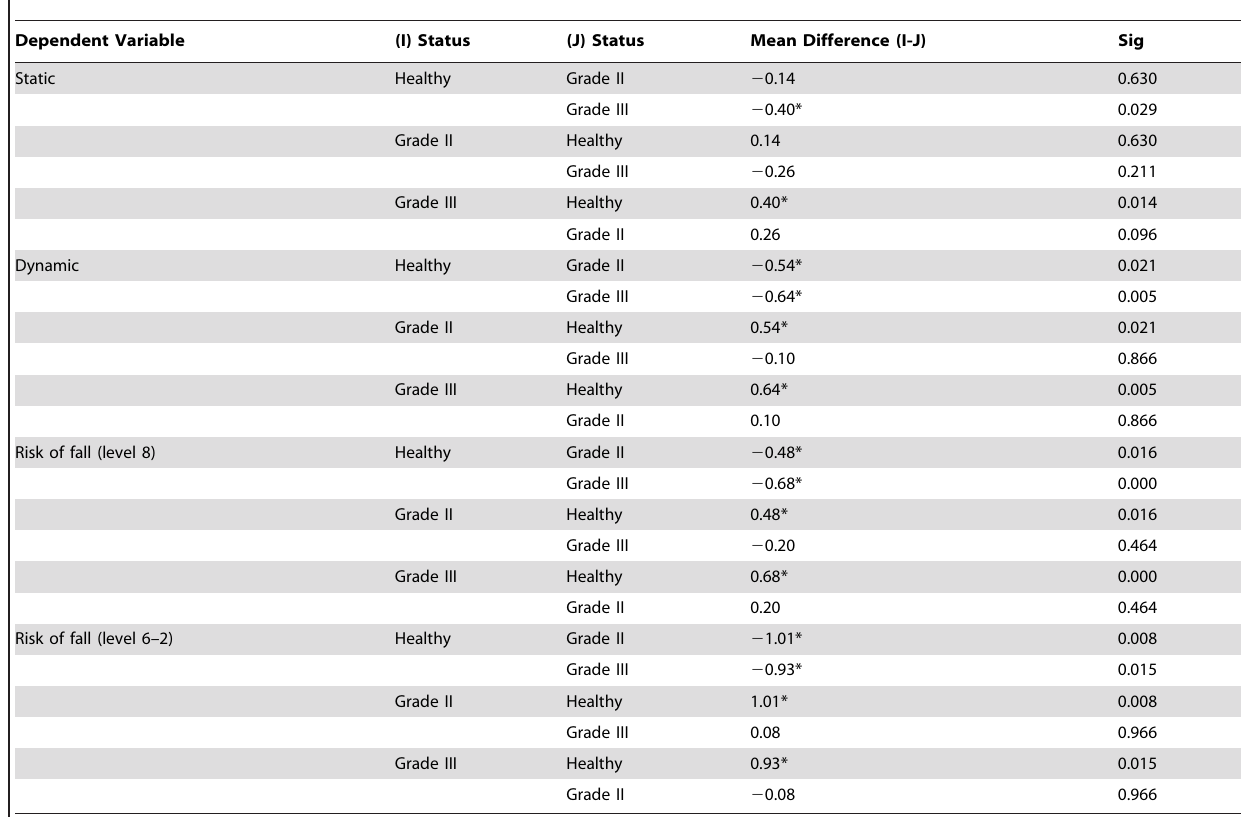
Table 4. ANOVA results for balance and risk of fall in defined feet